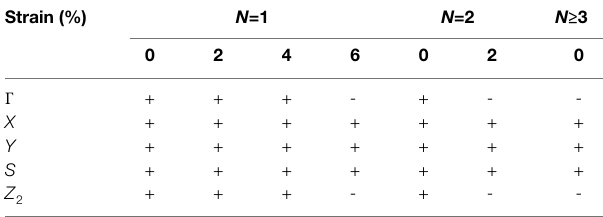
TABLE 1 | The computed parities of N -layer TiPI at TRIM under strain. The more precise critical strain can be found in the main text. The relaxed vdW interlayer spacing is adopted in this table. Bulk ( N → ∞ ) is also